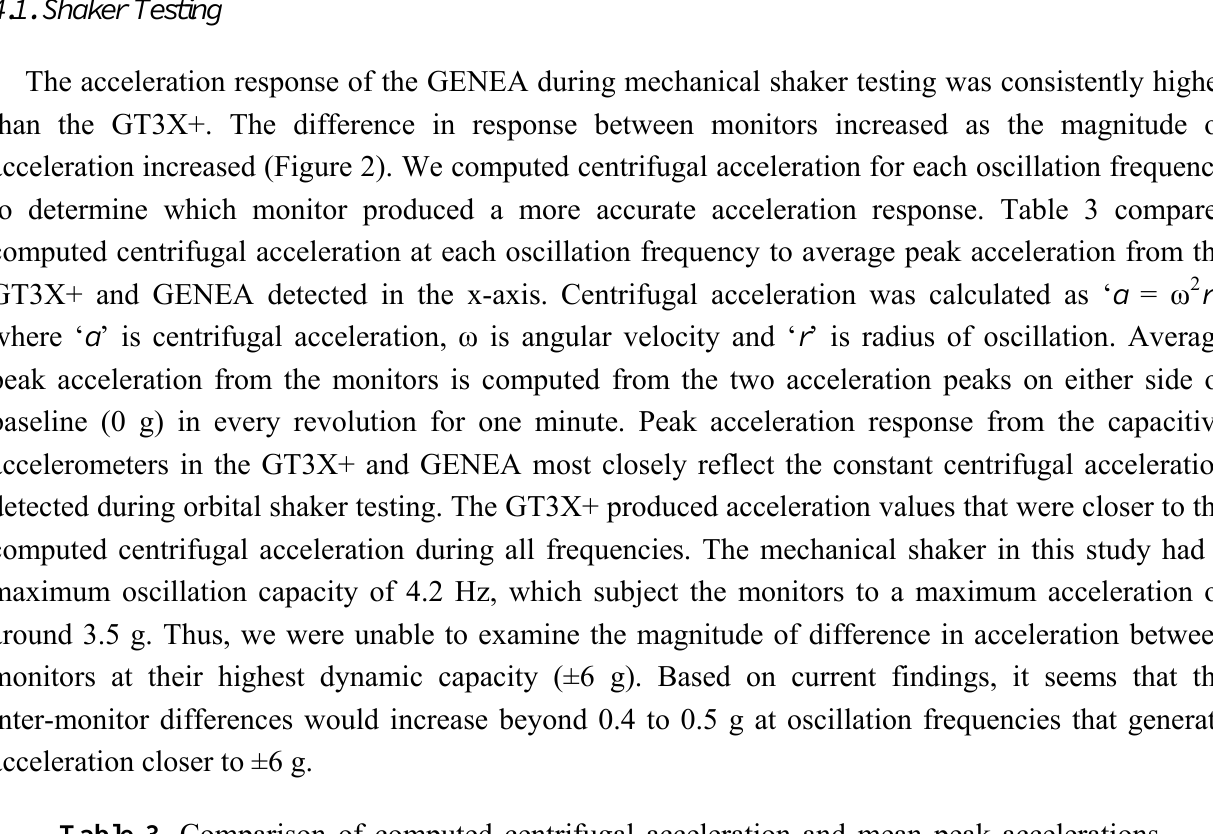
Table 3. Comparison of computed centrifugal acceleration and mean peak accelerations from the GT3X+ and GENEA monitors (x-axis) in